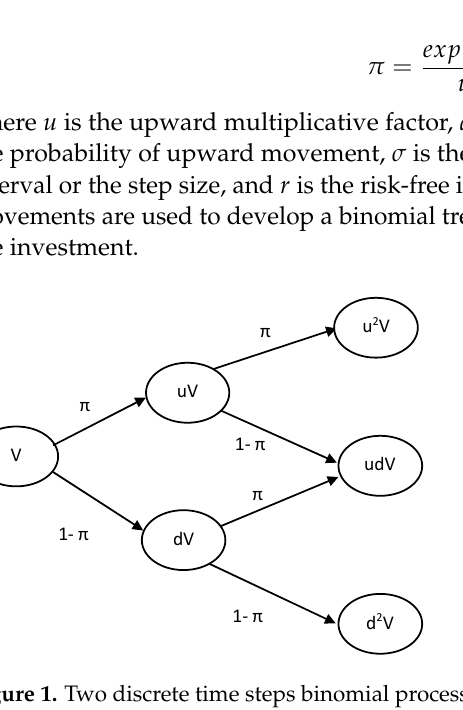
Figure 1. Two discrete time steps binomial process tree.